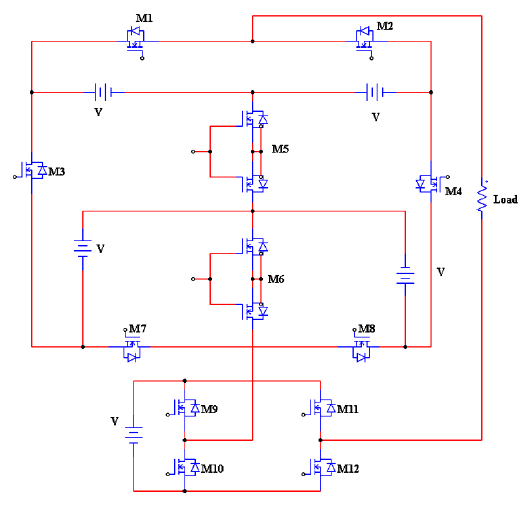
Figure 31. Circuit configuration for asymmetric MLI.